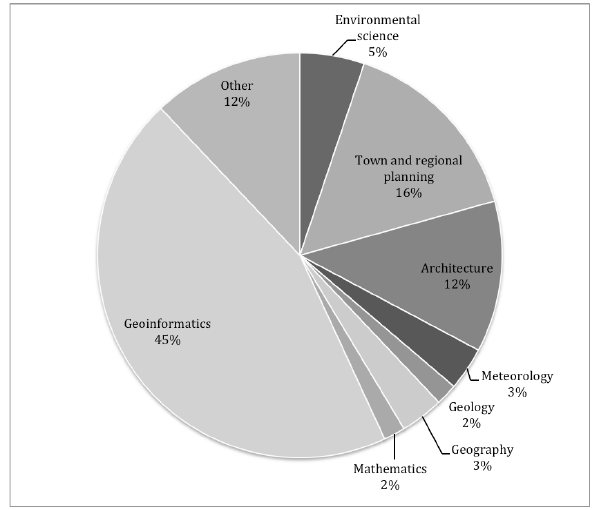
Figure 2. Overview of the participants in the distributed studies occupation